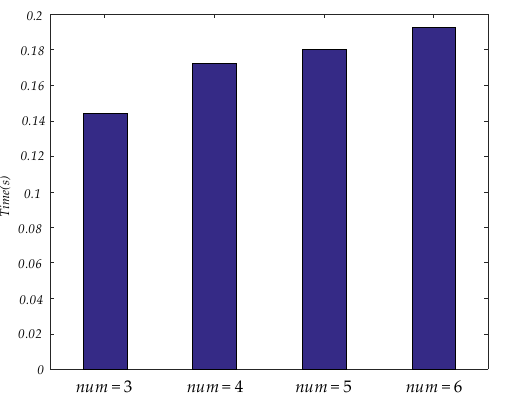
Figure 7. This figure shows the time consumed in tensor decomposition of dynamic functional brain networks with different num values.